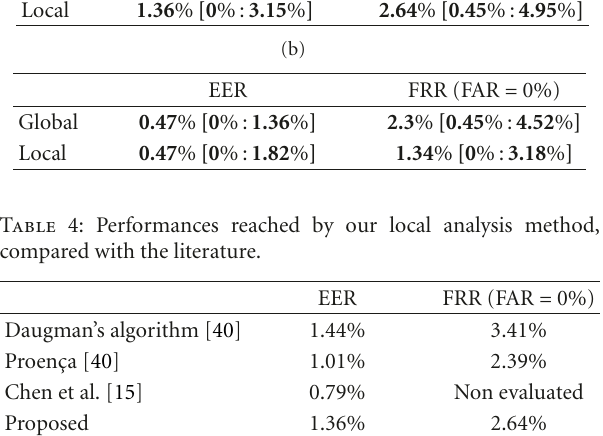
Figure 18: Examples of blurring with σ = 3. (a) CASIA image, (b) ISEP image.